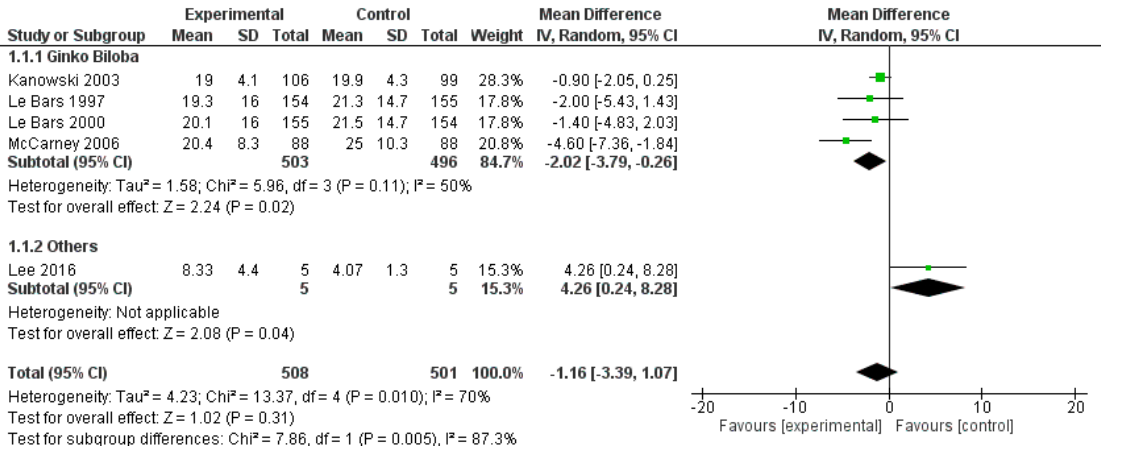
Figure 9. Pooled analysis of the impact of polyphenols on Alzheimer’s Disease Assessment Scale- cognitive subscale (ADAS-Cog).